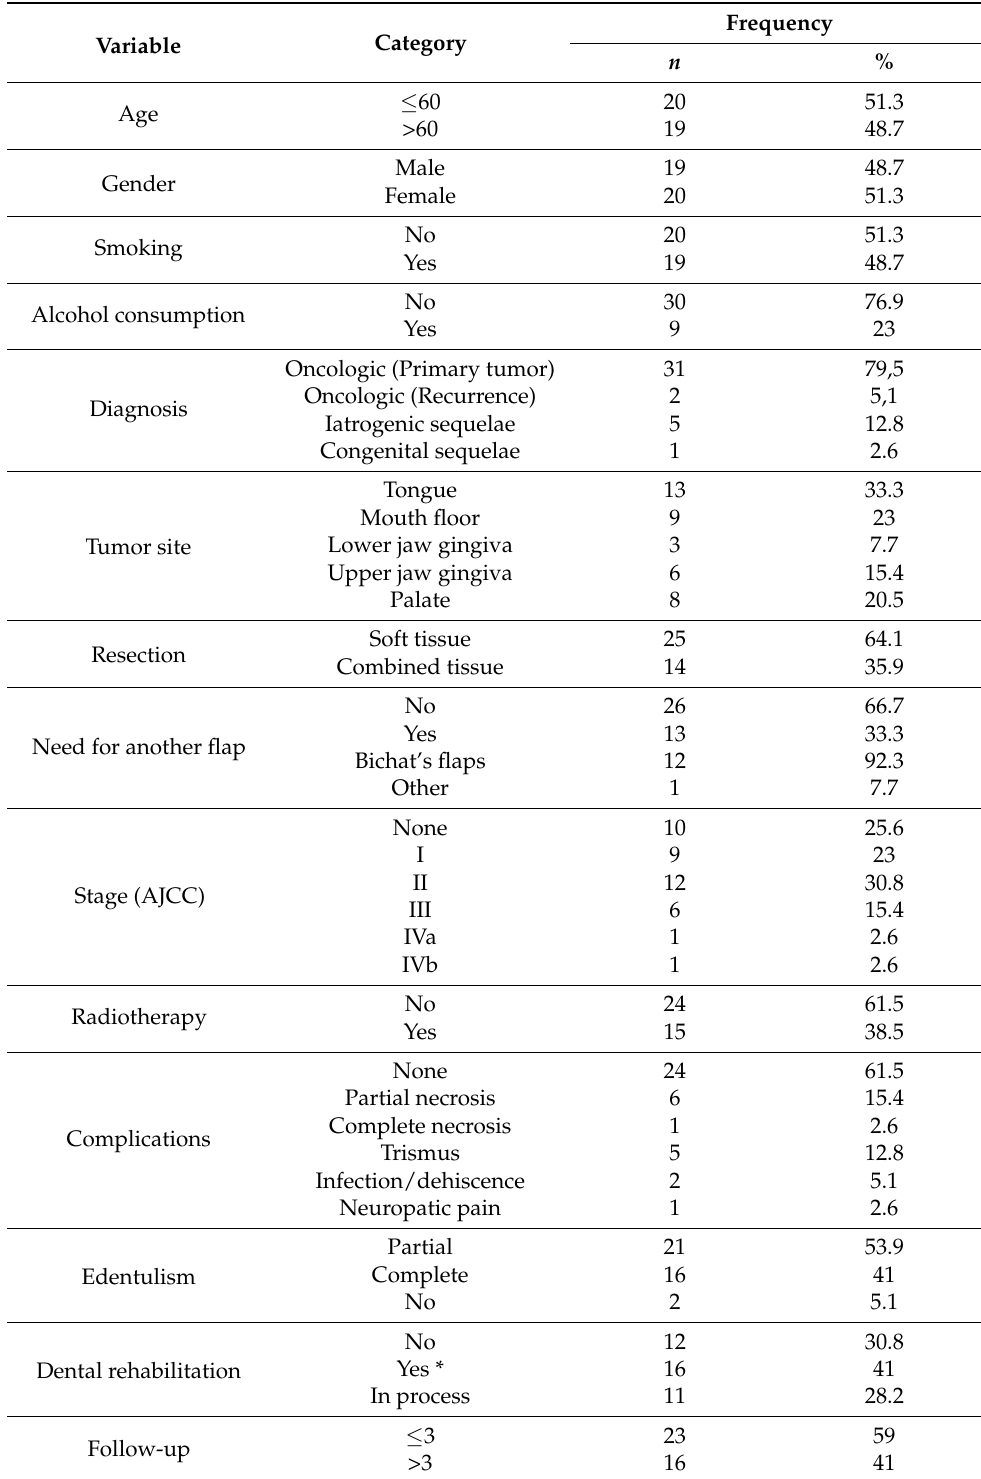
Table 1. Description of the socio-demographic and clinical